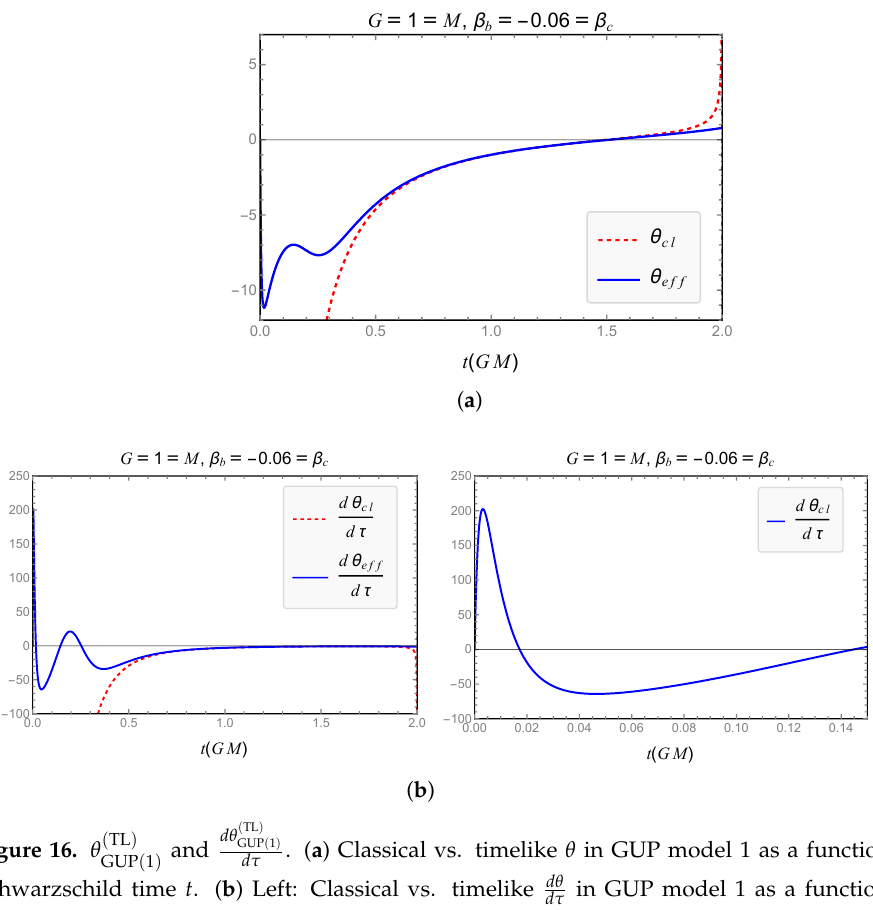
d θ ( TL ) GUP ( 1 ) go d τ